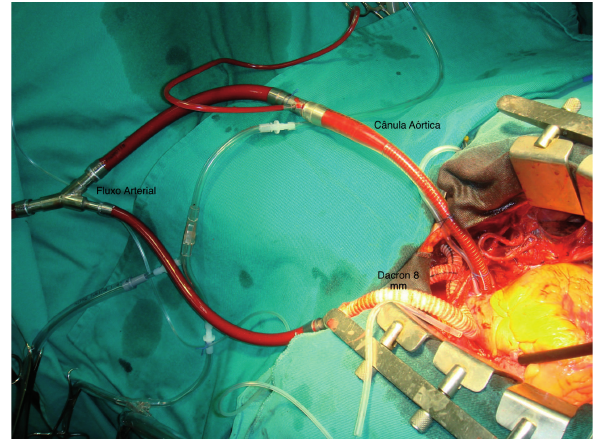
Fig. 1 - Documentação fotográfica do preparo para CEC. Sistema para perfusão da aorta ascendente e do enxerto de